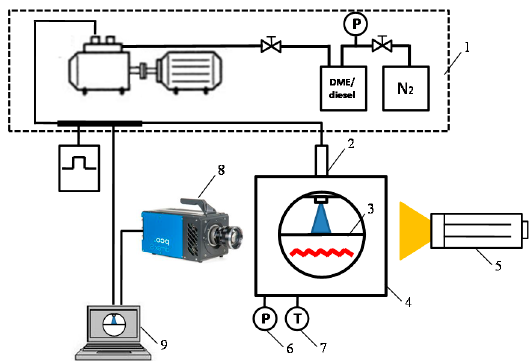
Figure 1. Visualization system for spray wall impingement (1—common-rail system; 2—nozzle; 3— impingement disk; 4—volume constant vessel; 5—light source; 6—pressure sensor; 7—temperature sensor;